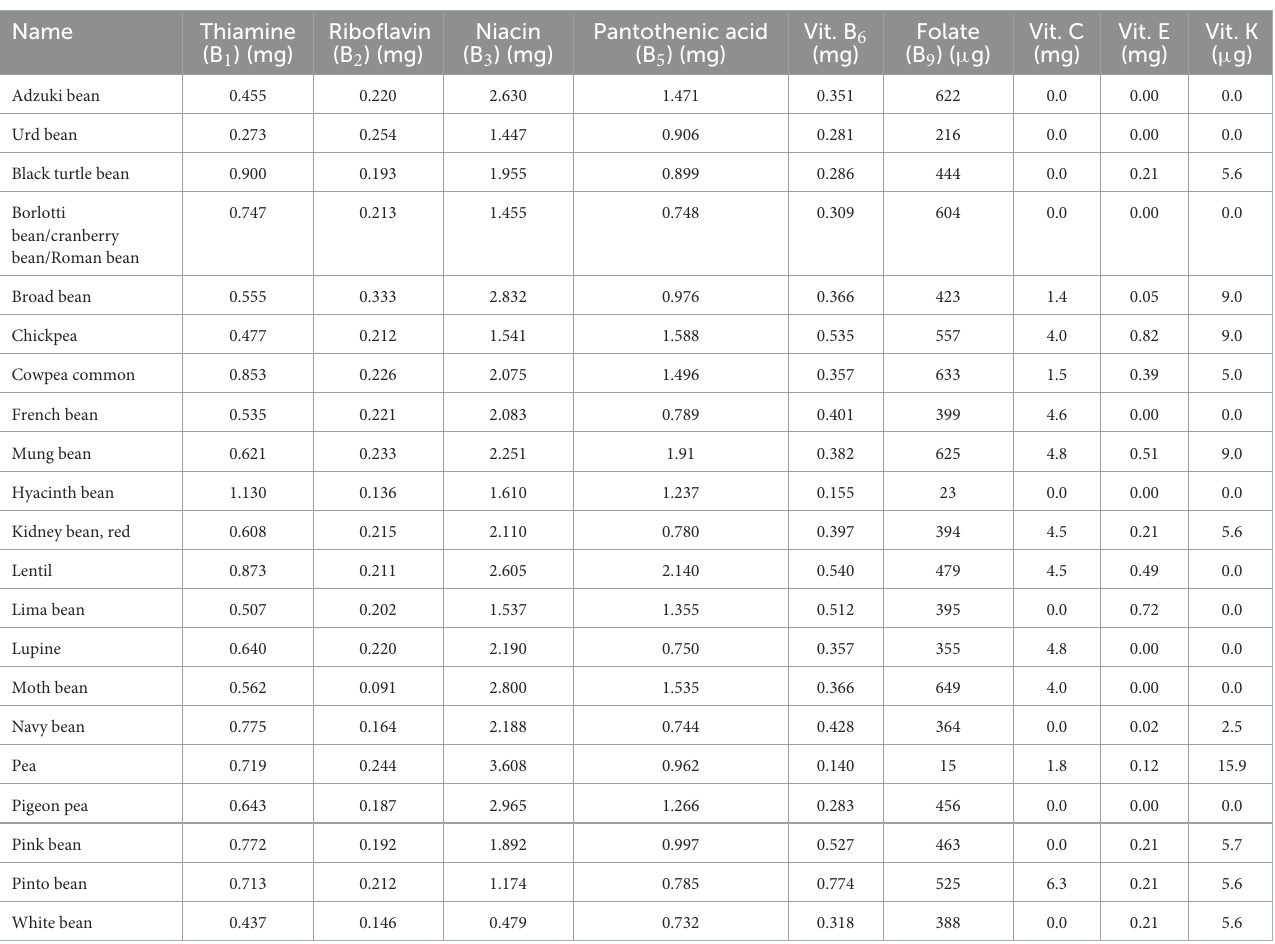
TABLE 6 Vitamin profile of common pulses (per 100g) ( https://www.nutritionvalue.org